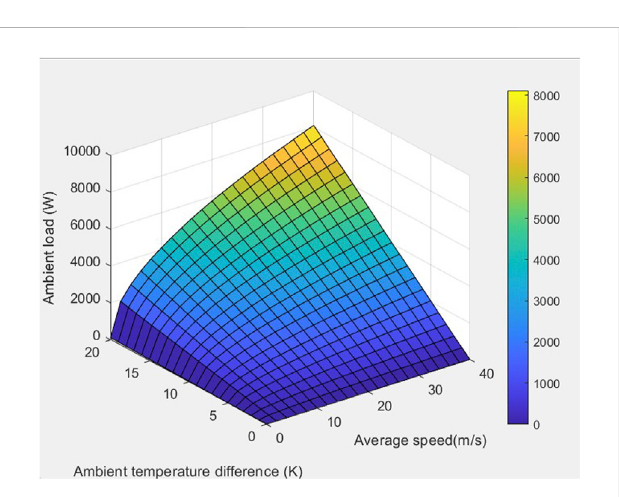
FIGURE 3 Ambient heat load distributionvs. average speed (m/s) andambient temperature difference